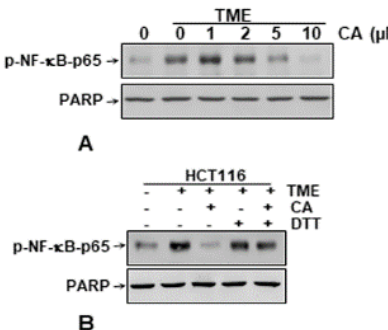
Figure 7. Direct effect of Calebin A (CA) on NF- κ B binding to DNA in CRC cells: Serum-starved HCT116 cells in alginate cultures from multicellular pro-inflammatory TME cultures were treated as described in Materials and Methods. A : Isolated nuclei from basal control HCT116 cells or HCT116 cells from multicellular TME, incubated with the indicated concentrations of Calebin A for 30 min, PARP served as an internal loading control in all experiments. B : Isolated nuclei from HCT116 basal control or multicellular TME, incubated for 30 min with 5 µ M Calebin A in the presence or absence of blotting. PARP served as an internal loading control in all